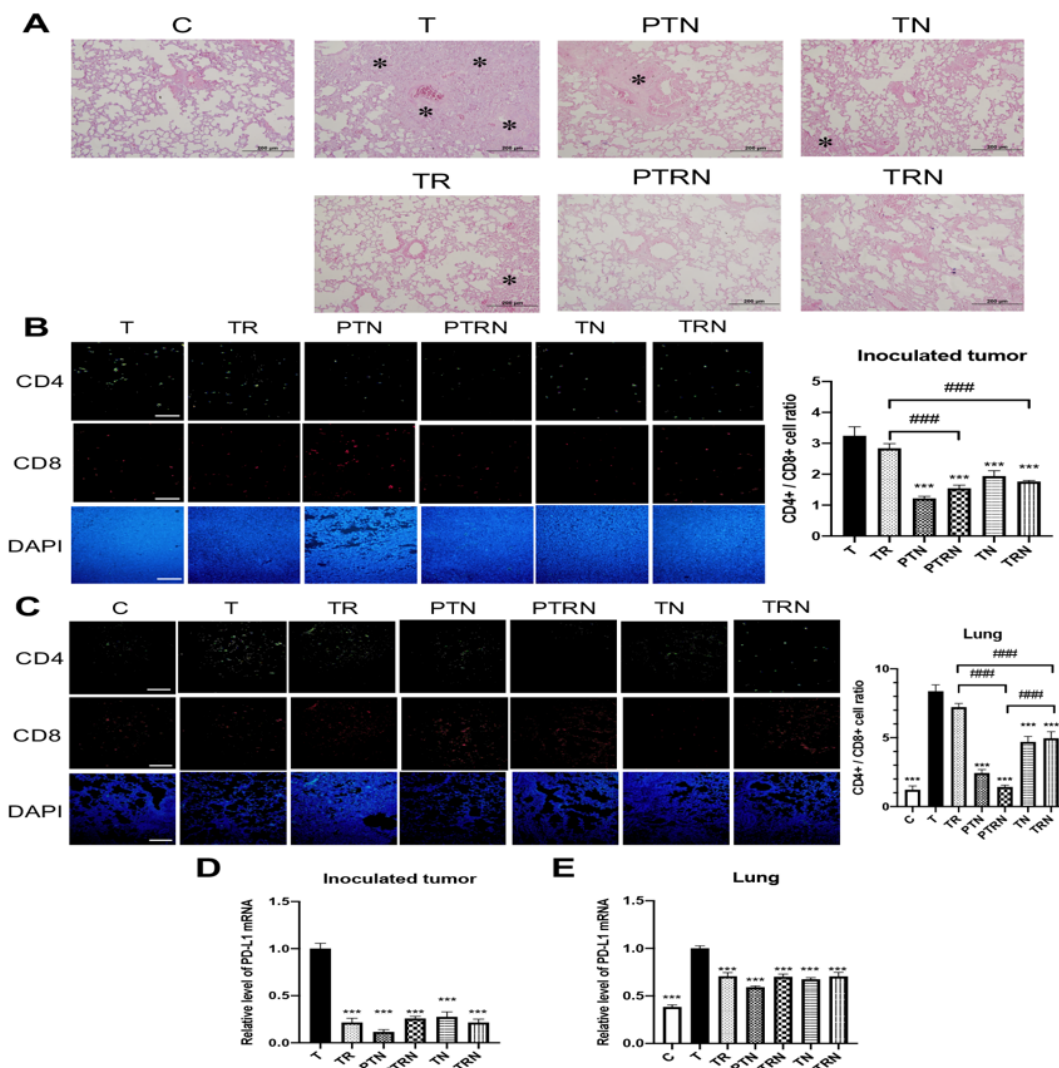
Figure 5. Total nutrition formula enhances the anticancer immunity of radiotherapy. ( A ) Hematoxylin and eosin (H&E) staining of lung tissues. Spots indicate metastatic tumors. Scale bar = 200 µ m. ( B ) Immunofluorescence analysis for CD4 + (green) and CD8 + (red) T cells in inoculated tumor tissues. Scale bar = 200 µ m. ( C ) Immunofluorescence analysis for CD4 + (green) and CD8 + (red) T cells in lung tissues. Scale bar = 200 µ m. ( D ) The relative expression level of PD-L1 mRNA in the inoculated tumor. ( E ) The relative expression level of PD-L1 mRNA in the lung metastatic tumor. Six tissue sections of each group were selected for immunofluorescence analysis and statistical analysis. Data are expressed as means ± SD. ***, p < 0.001 as compared to the T group. ###, p < 0.001 as compared between two groups.